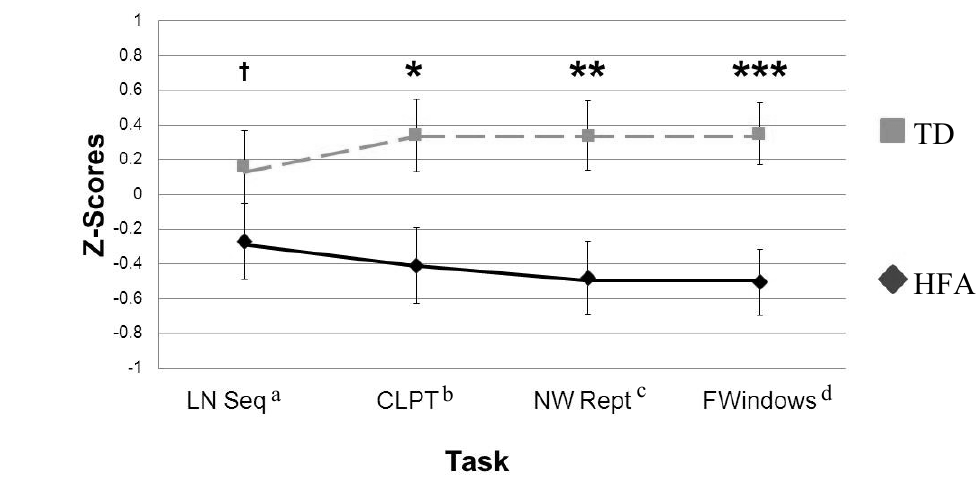
Figure 1. Working memory abilities as a function of diagnostic group. Graph excludes two outliers for Letter-Number Sequencing. † p < 0.10; * p < 0.05; ** p < 0.01; *** p < 0.001. a Letter-Number Sequencing; b Competing Language Processing Task; c Non-word Repetition; d Finger Windows.